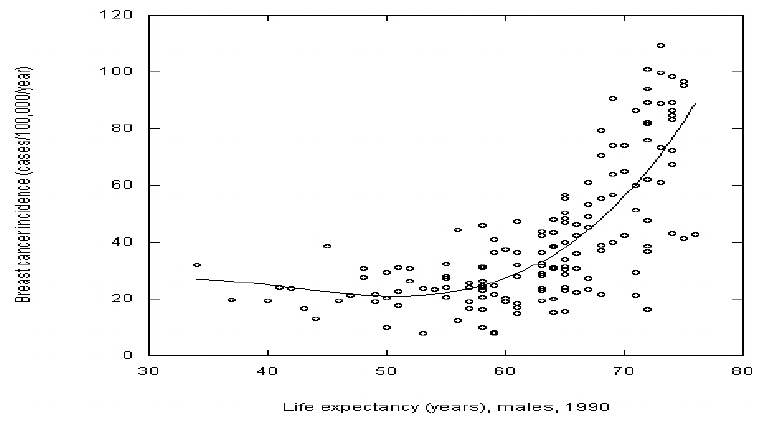
Figure 1. Breast cancer incidence rates for 2008 vs . life expectancy for males in 1990 with a third order